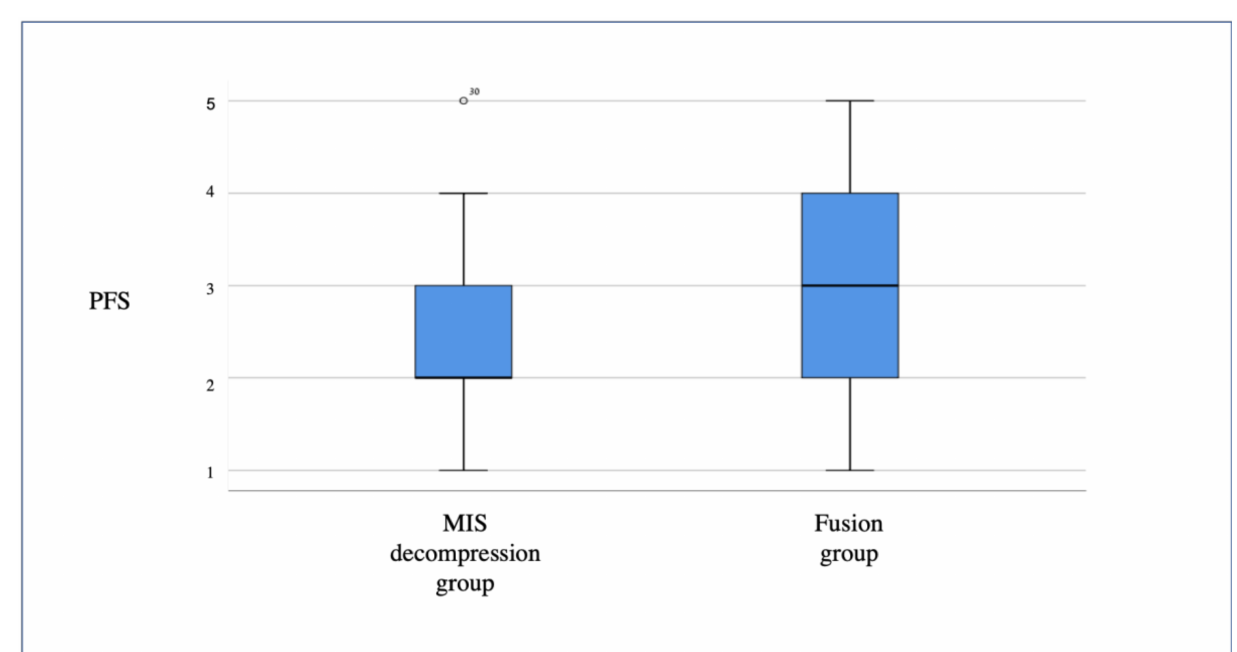
Figure 3. Distribution of back and leg pain frequency for the MIS and fusion groups.